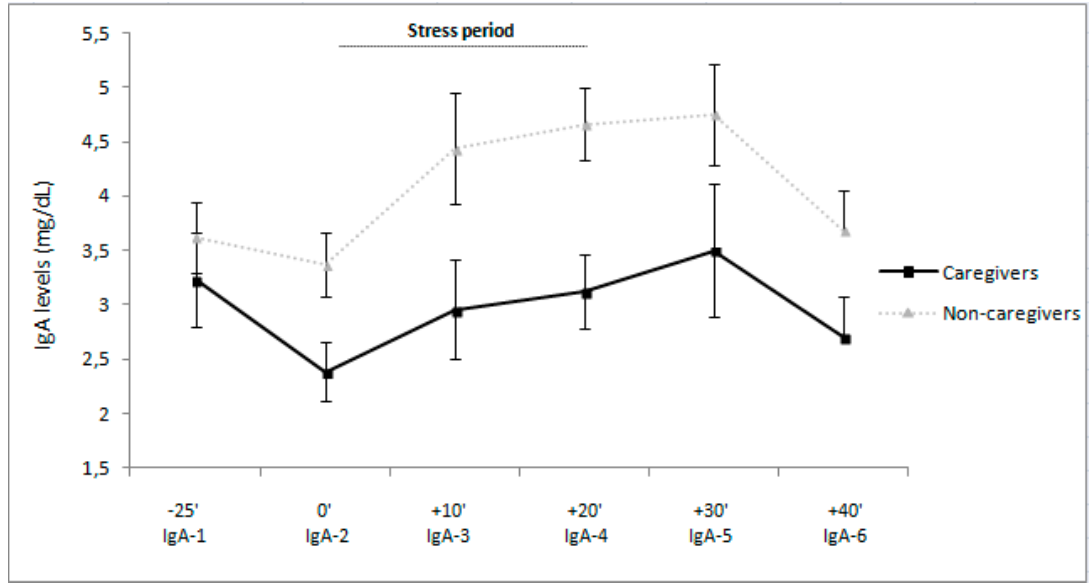
Figure 2. Estimated marginal means and standard errors of means of immunoglobulin-A (IgA) levels in caregivers and controls.